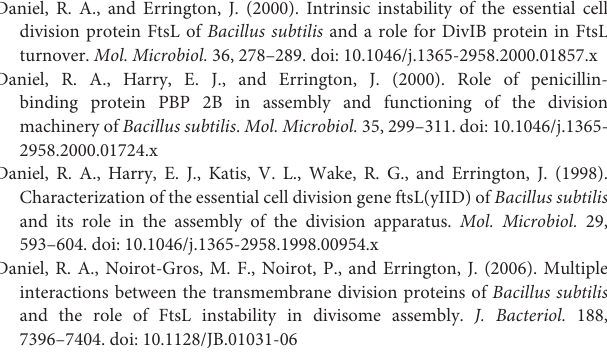
Figure S1 | Comparison of FtsW and PBP 2B/FtsL depleted germinating spores. Spores of strain PG80 ( P spac -ftsW, amyE :: Pxyl-gfp-ftsZ ) (A) and of strain PG114 ( P spac -yllB-ylxA-ftsL-pbpB, amyE :: P xyl -gfp-ftsZ ) (B) were germinated at 37 ◦ C in germination medium, in the absence of IPTG and in the presence of 0.25% xylose. Phase contrast and GFP images were taken 5 h after the beginning of the heat shock. Scale bar indicates 5 µ m. Figure S2 | Stability of PBP 2B upon depletion of FtsW. Spores of strain PG87 ( P spac -ftsW, P xyl -gfp-pbpB ) were germinated at 37 ◦ C in the presence of 0.5% xylose and in the presence or absence of IPTG 1 mM. (A) Optical density measured at 600 nm, arrows indicate time points at which samples were collected. (B) Western blot analysis of PBP 2B levels in samples collected 3, 4, or 5h after the beginning of